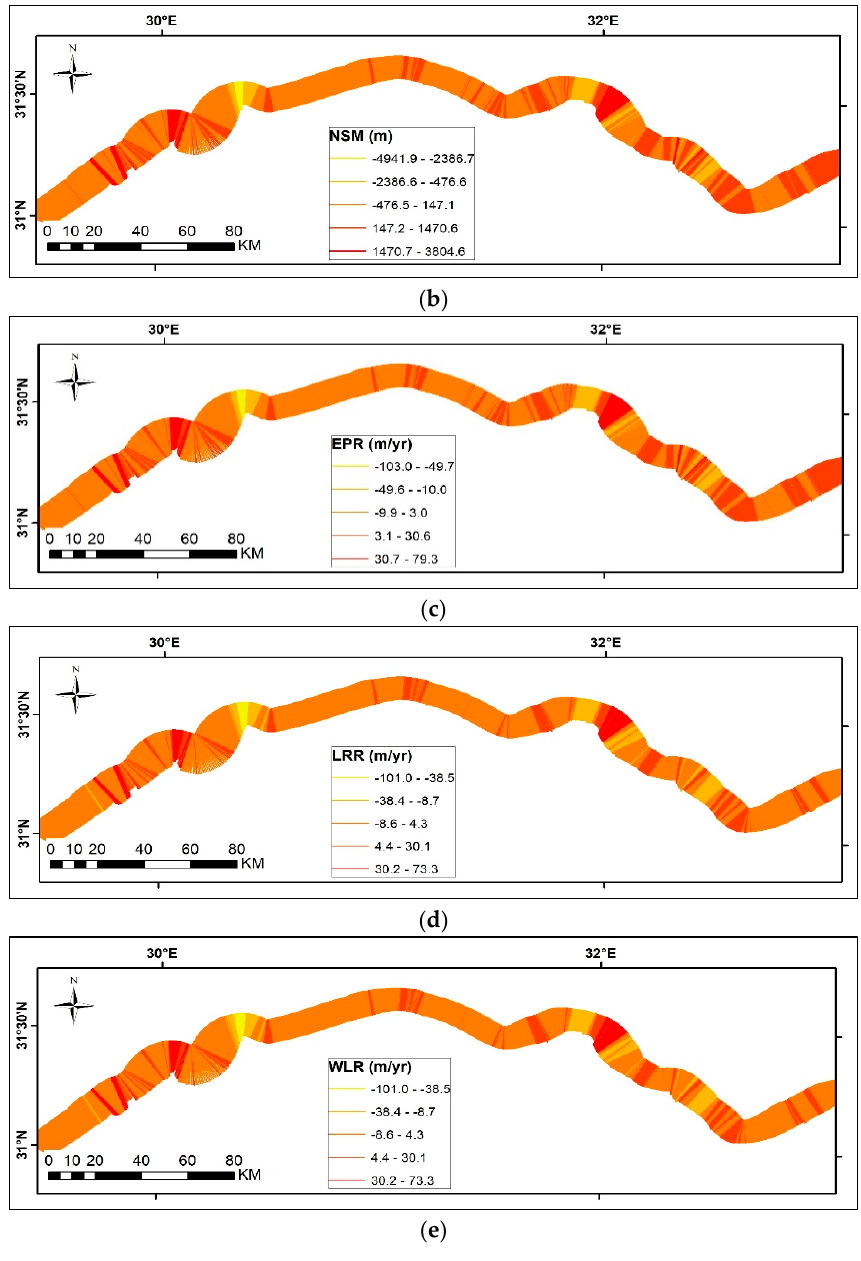
Figure 6. The results of SCE, NSM, EPR, LRR, and WLR at the Nile Delta for the period 1974–2043: ( a ) SCE, ( b ) NSM, ( c ) EPR, ( d ) LRR, ( e ) WLR.